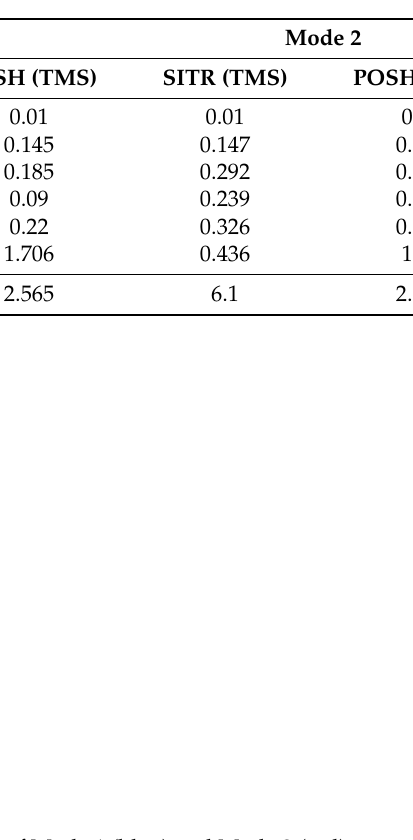
Figure 5. Overall operational time comparison of Mode 1 (blue) and Mode 2 (red).